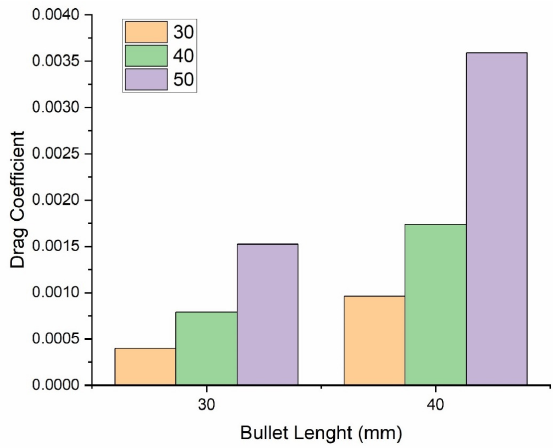
Figure 8. Experimental values of drag coefficient of 30 mm and 40 mm bullet heads (design I) at 30°,40°,and 50° angle of attack. Table 3. Simulated and experimental values of drag coefficient of bullet heads of 30 mm, 40 mm, and 50 mm at varying angles of attack.